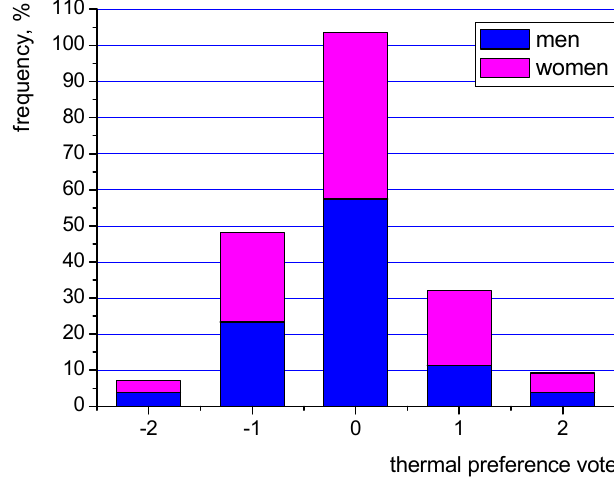
Figure 10. Thermal preference of the room occupants in both intelligent buildings based on 1369 questionnaires (description in the text).